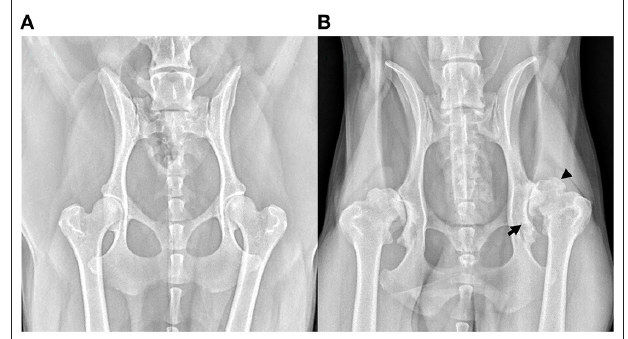
FIGURE 3 | Ventrodorsal extended limb radiographs highlighting hip osteoarthritis (OA). (A) Radiograph of an adult dog with radiographically normal hips. (B) Radiograph of a middle-aged, male, large-breed dog with severe OA secondary to hip dysplasia. This radiograph shows evidence of advanced new bone formation (osteophytosis, black arrow head), sclerosis and remodeling of the acetabulum (black